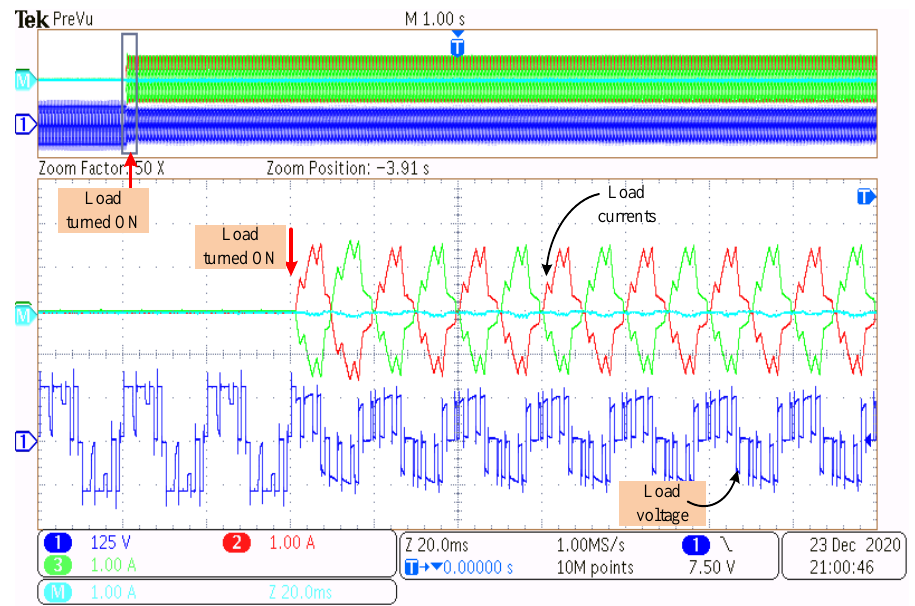
Figure 15. Experimental results using UVSVPWM under unbalanced load conditions (with one of the phases kept open).